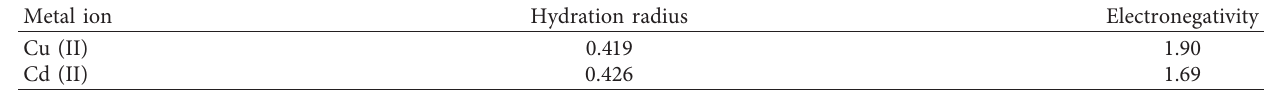
Table 6: Basic properties of Cu (II) and Cd (II).